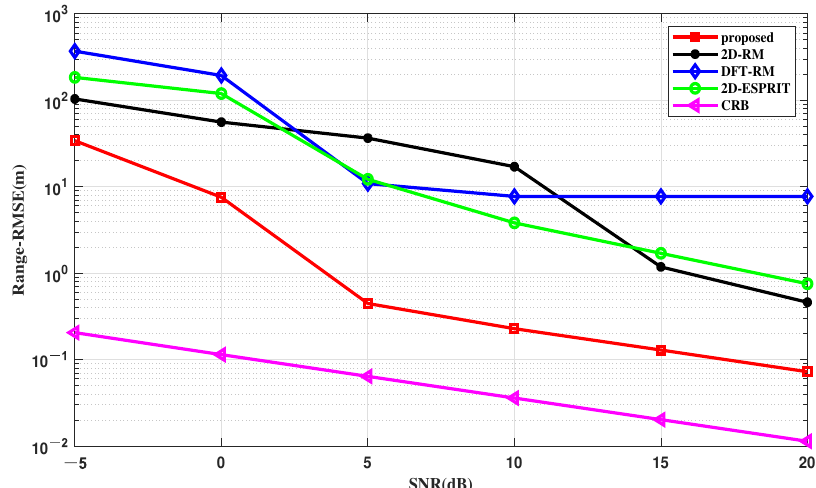
Figure 8. RMSE of the range estimation versus the SNR.